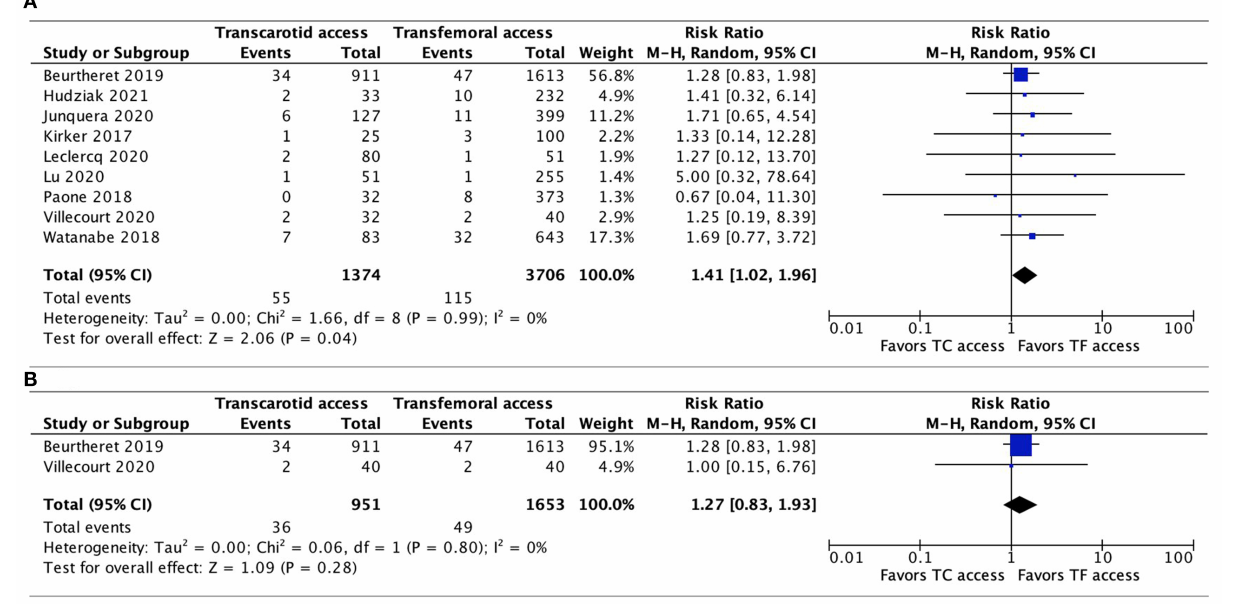
FIGURE 2 | Forest plots comparing 30-day all-cause mortality rates between TC and TF transcatheter aortic valve replacement procedures. (A) Pooled data from all studies. (B) Pooled data from propensity-score matched studies. TC, transcarotid; TF,